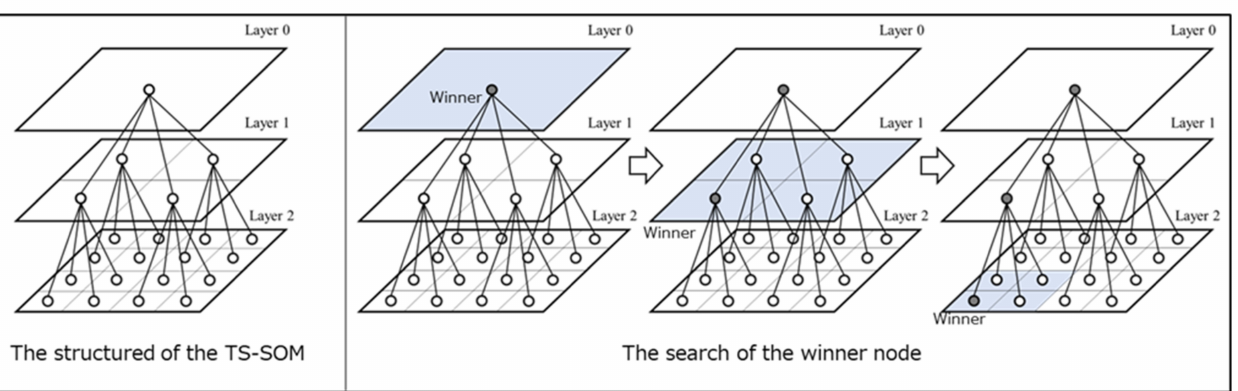
Figure 2. Structure of the TS-SOM and how to determine the winner node.